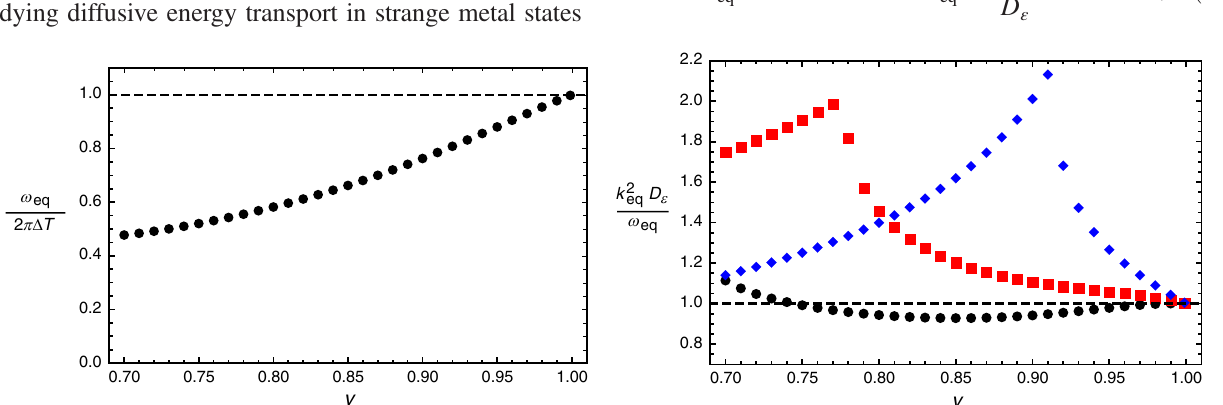
FIG. 7. Local equilibration frequency (left) and diffusivity ratio (right) for the large- q SYK chain model. ω the diffusivity ratio is shown for γ ¼ 1 (black circles), γ ¼ 0 . 4 (red squares), and γ ¼ 0 . 2 (blue